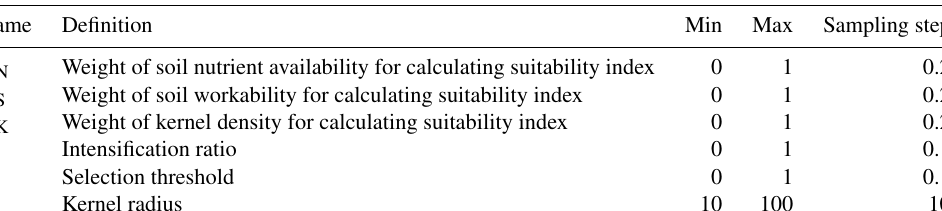
Table 2. Key parameters and their sampling range and steps for calibration in this study.